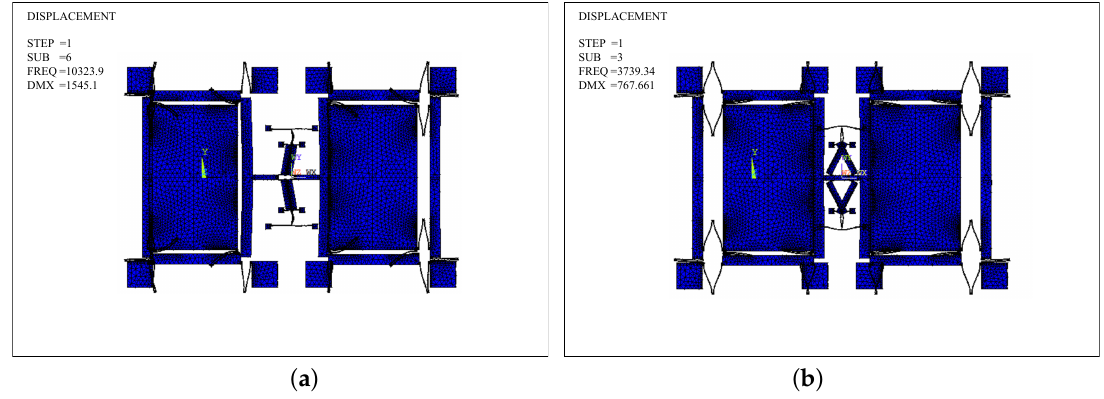
Figure 14. Modal analysis of the Type-B structure: ( a ) the in-phase mode; ( b ) the anti-phase